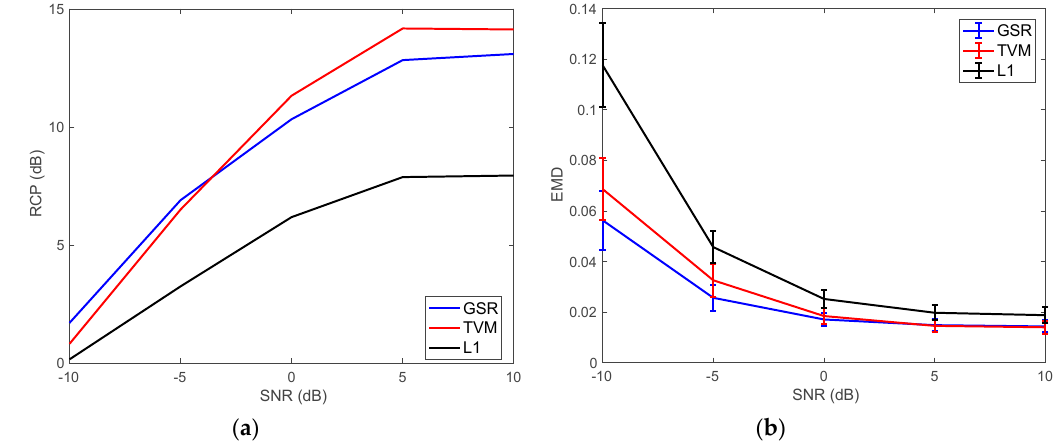
Figure 10. Quantitative metrics vs. SNR for composite target scene reconstruction using two Figure10. Quantitativemetricsvs. SNRforcompositetargetscenereconstructionusingtwotransmitters transmitters and six receivers. ( a ) RCP; ( b ) EMD (average and variance). and six receivers. ( a ) RCP; ( b ) EMD (average and